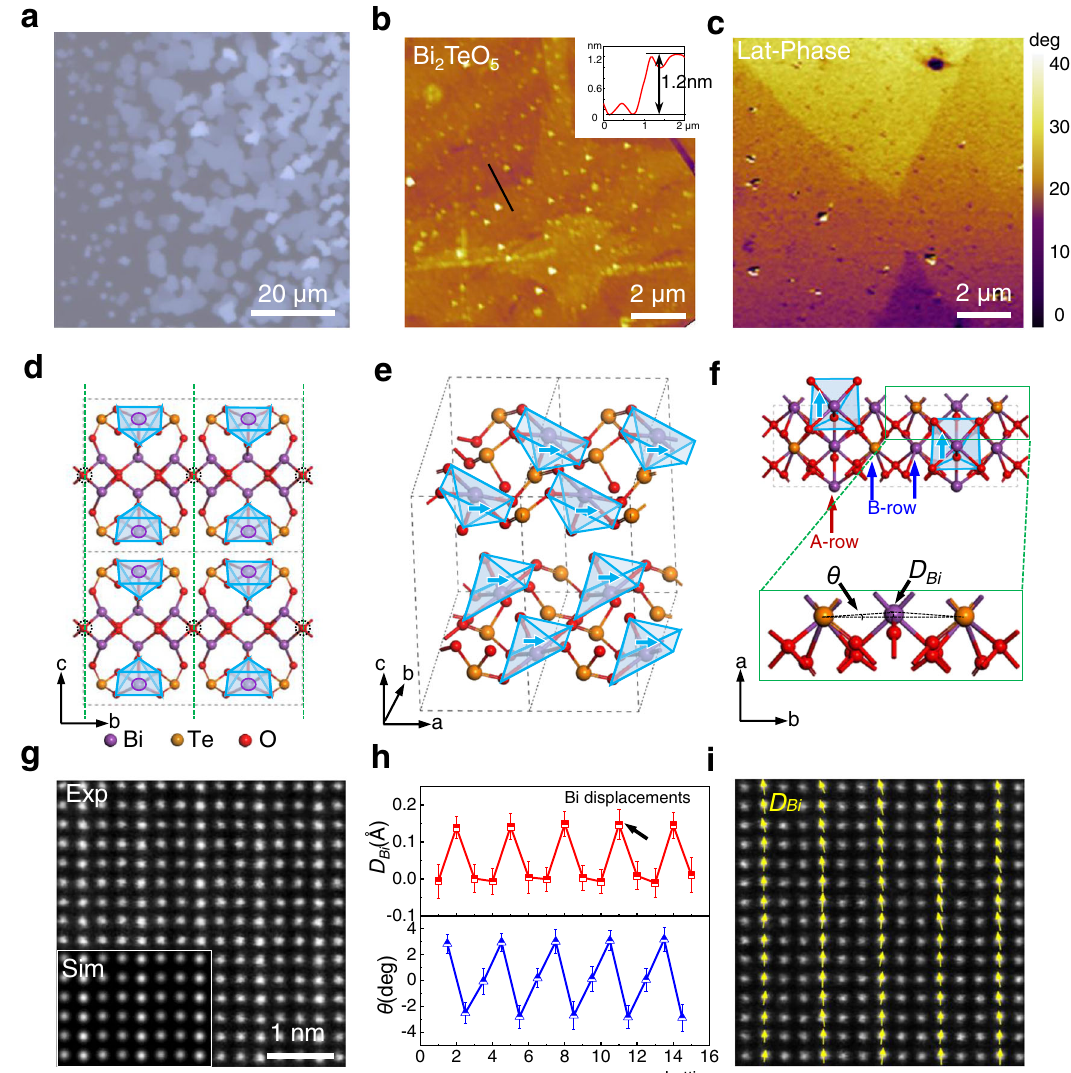
Fig. 1 | CVD growth of layered 2D Bi 2 TeO 5 single crystals with ferroelectricity. a OpticalimageofBi 2 TeO 5 singlecrystals. b , c AFMtopographyandcorresponding lateralPFMimagesofsingleBi 2 TeO 5 fl ake.Heightpro fi leinbshowsastepof1.2nm, consistent to the thickness of monolayer Bi 2 TeO 5 . d Schematic of Bi 2 TeO 5 crystal structurealong a axis. e Top oblique view oflayered Bi 2 TeO 5 crystalstructure. The blue pyramids correspond to the BiO 5 cages. The blue arrows represent the polarization direction of BiO 5 cages. The sandwiched Bi-O-Bi sublayers are not shownhereforbetterpresentation. f SchematicofBi 2 TeO 5 crystalstructurealong c rowscomprised ofBi 3+ sitesintheBiO 5 cagesarenamed asA-rows, and the Bi 3+ and Te 4+ cations beside the mirror plane are distinguished as B-rows. The Bi 3+ cation displacements ( D Bi ) and lattice rotation angle ( θ ) are used to characterize the polarization feature (enlarged green rectangle in Fig. 1f), which can be directly acquired and mapped experimentallybyusingaberrationcorrectedSTEMasshowninFig.1g.